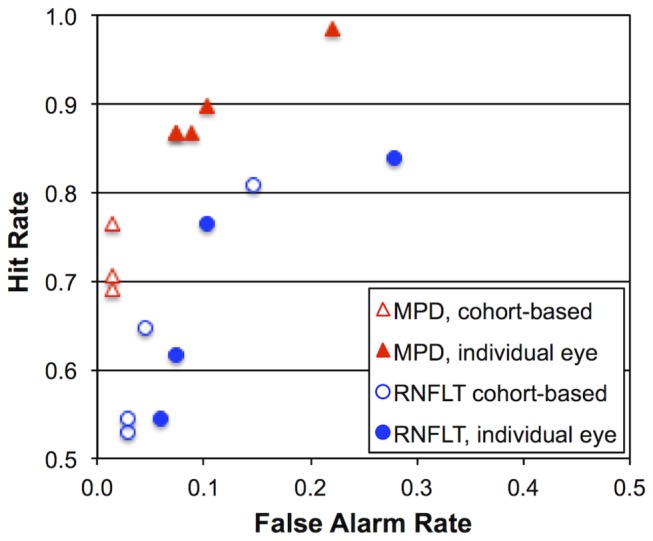
Receiver-operating characteristic (ROC) plot comparing the parameter MPD versus the average peripapillary RNFL thickness for the eight different endpoint criteria.Hit rate, which represents the proportion of EG eyes reaching endpoint by a given criterion, is plotted against false alarm rate, which represents the proportion of fellow control eyes reaching endpoint by the same criterion. Note, this plot is truncated at 0.5 along both axes, so it represents only the top left quadrant of a complete ROC plot.